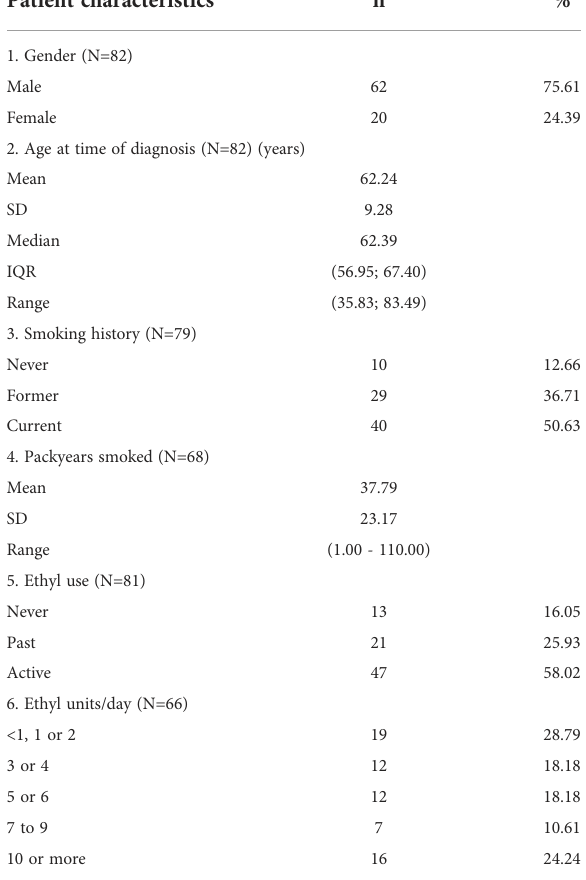
TABLE 1 Patient